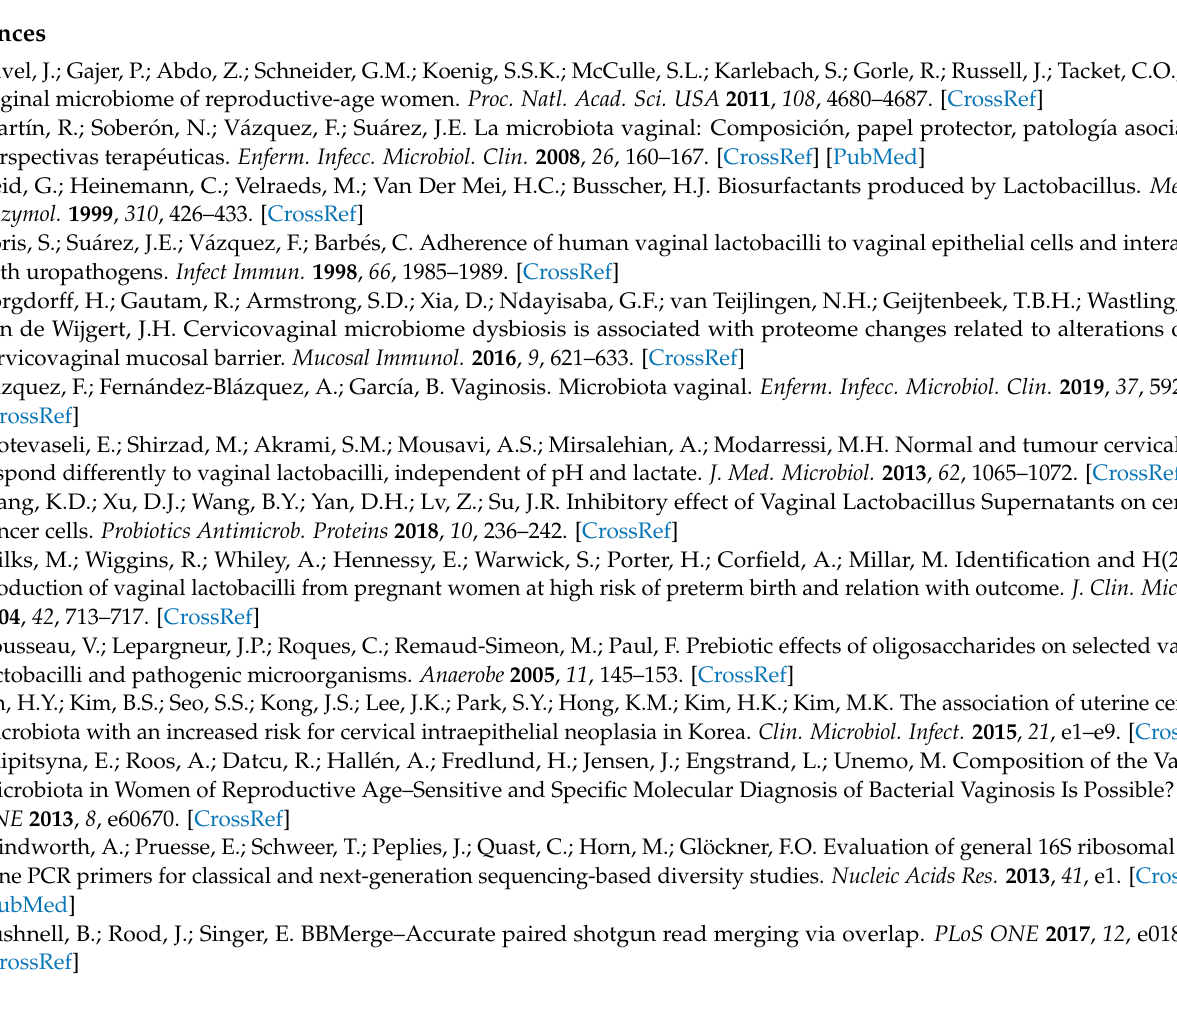
Figure A1. Vaginal microbial communities found in patients represented by colors. Vaginal types II and V are underrepresented in the study population. PC1: principal component 1. PC2: principal component 2. PC3: principal component 3.